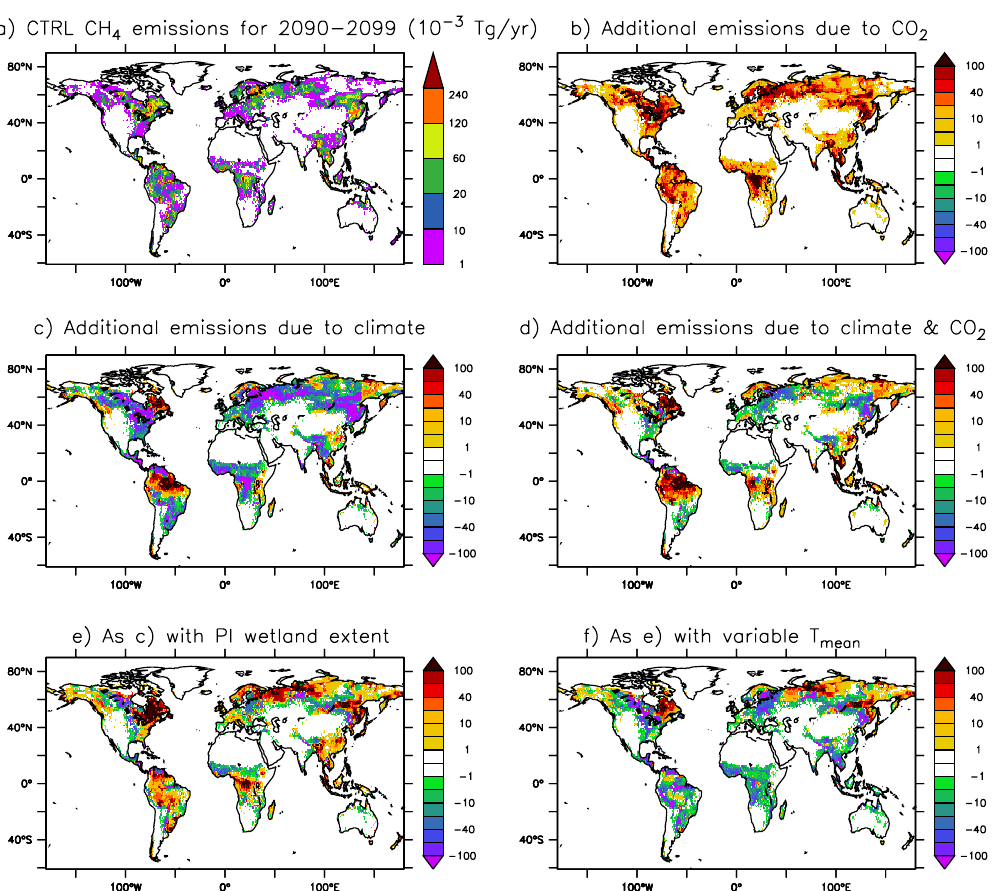
Fig. 3. Mean annual CH 4 emissions by wetlands over 2090–2099 period for CTRL simulation (a) and changes in emissions due to increase in atmospheric CO 2 (b) , climate change (c) and both (d) .The shown changes in emissions are obtained by ORCHIDEE-WET simulations with Q 10 =3, constant in time T mean and accounting for wetland extents variation, which is the basic configuration. Climate effect on CH 4 flux densities alone (i.e. without accounting for wetland extent evolution, see above) is given in (e) . (f) displays the change in CH 4 flux densities due to climate but obtained with a T mean variable in